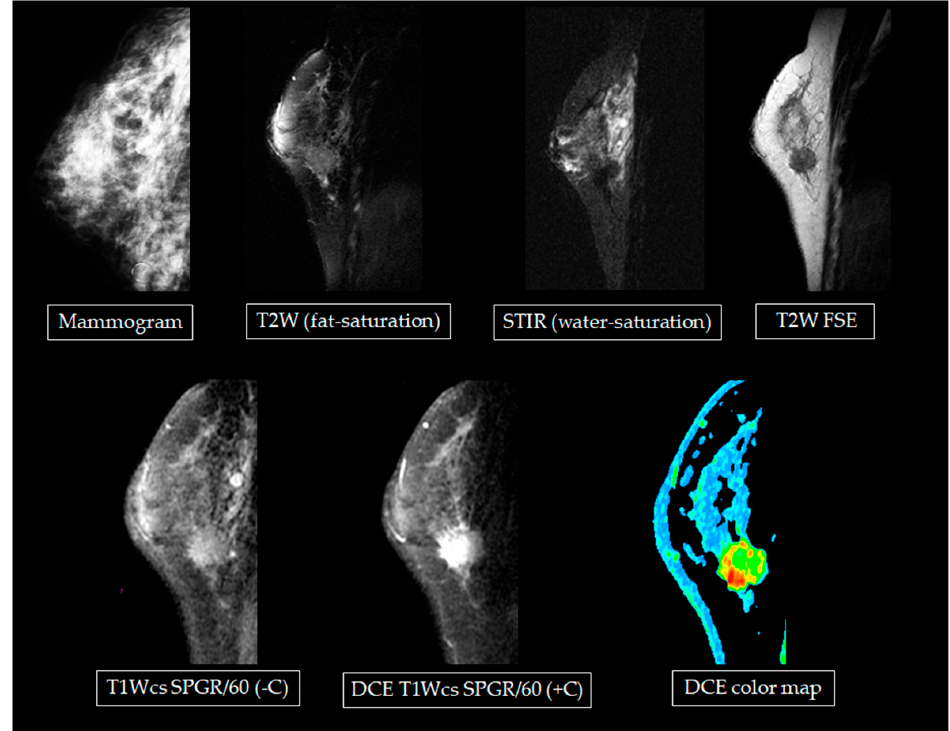
Figure 3. Siliconoma with in-situ carcinoma using various imaging techniques.